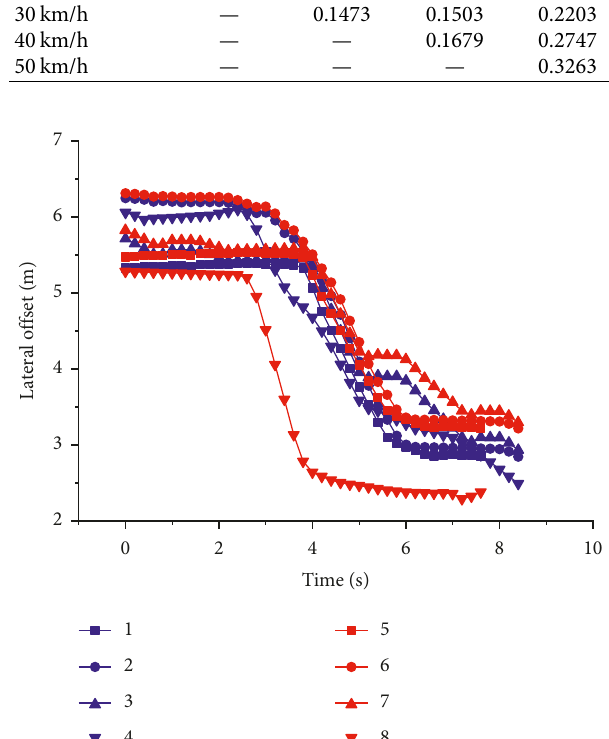
Figure 7: Comparison of lane change tracks between skilled drivers and NGSIM